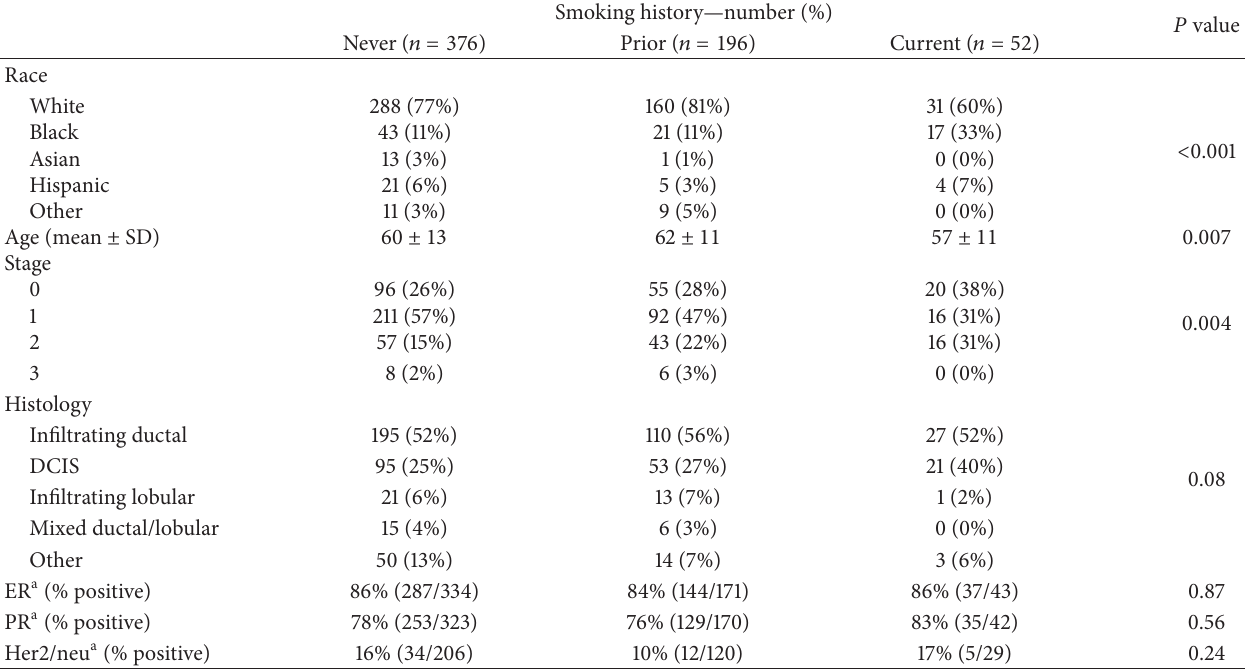
Table 1: Demographic and tumor characteristics of sample by smoking